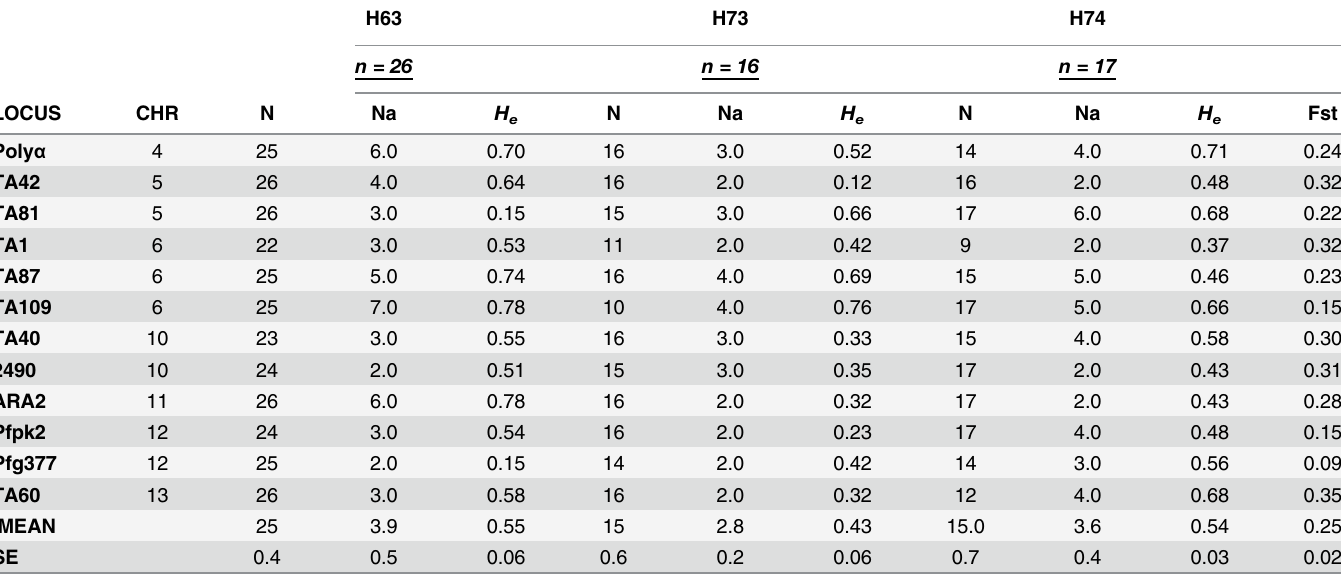
Table 1. Parasite genetic diversity for the three parasite lines. He is the unbiased expected heterozygosity, N is the number of samples analysed, Na is the number of alleles and Fst is the fixation